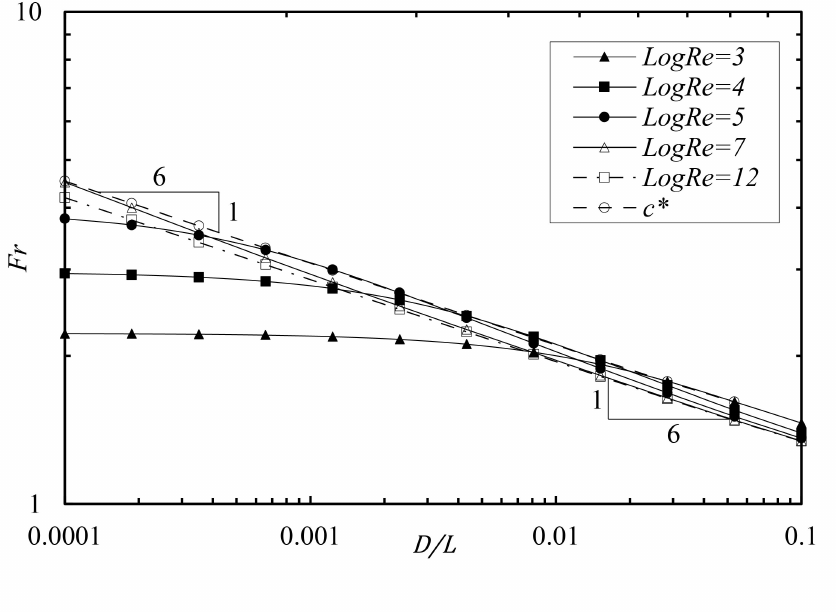
Figure 6. The function value, Ψ − 1/2 ( Re , t ) , plotted against D / L for several typical Reynolds